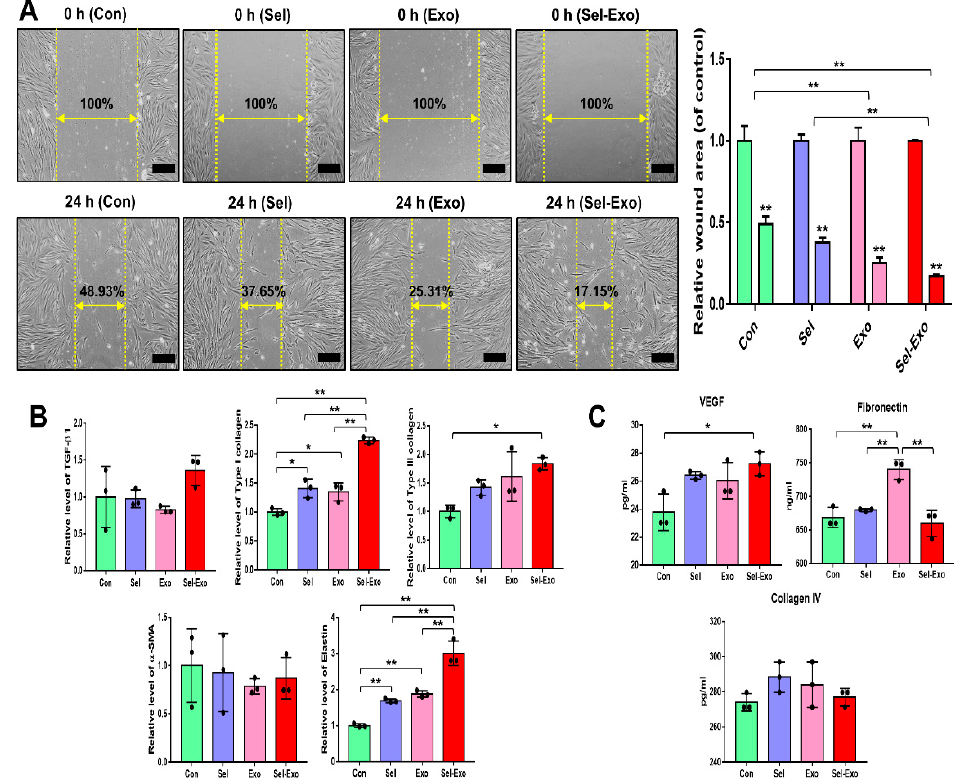
Figure 6. Migration of human dermal fibroblasts in the presence of selenium, exosomes, and selenium-treated exosomes. ( A ) Optical images of migrated fibroblasts were obtained from the in vitro scratch-wound-closure assay, and the relative migration rates of the fibroblasts were quantified (100 × magnification, scale bar = 200 µ m). ( B ) Relative mRNA expression levels were evaluated by real-time PCR. ( C ) Relative protein levels of the corresponding beneficial factors for wound healing were determined by multiplex assay. A representative image of three independent experiments is shown. Data are expressed as the mean ± SD of three independent experiments. * Significant difference from control, p < 0.05. ** Significant difference from control, p < 0.01.